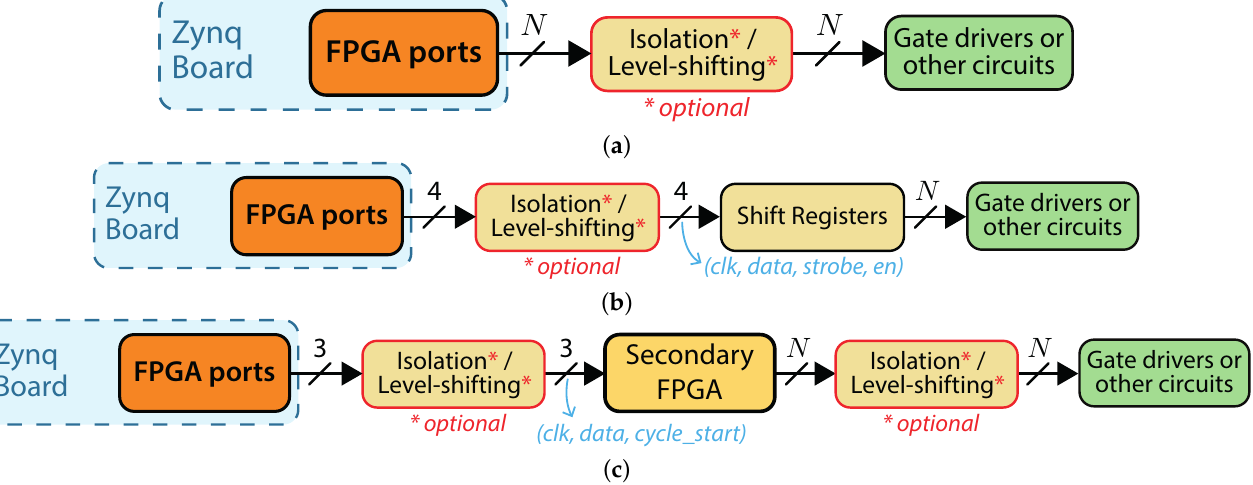
Figure 2. Proposed techniques for digital output implementation and expansion. ( a ) Direct connection of FPGA ports to the target circuit. ( b ) Expansion of available output ports using shift registers. ( c ) Expansion of available output ports using a secondary FPGA for port